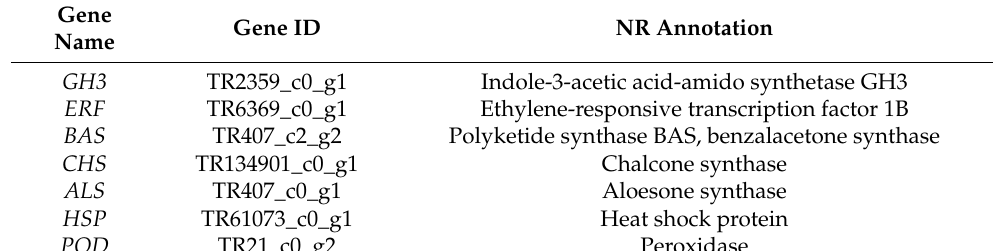
Table 2. The annotation of selected functional genes.